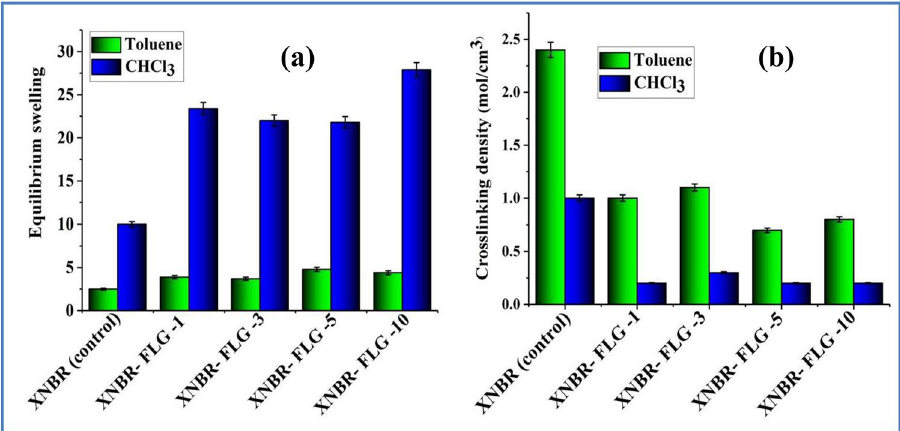
Figure 1. Swelling studies on FLG incorporated XNBR nanocomposite thin films in toluene and chloroform; ( a ) equilibrium swelling ( b ) crosslinking density. The numbers (1, 3, 5 and 10) in X axis indicates wt% of the FLG with respect to